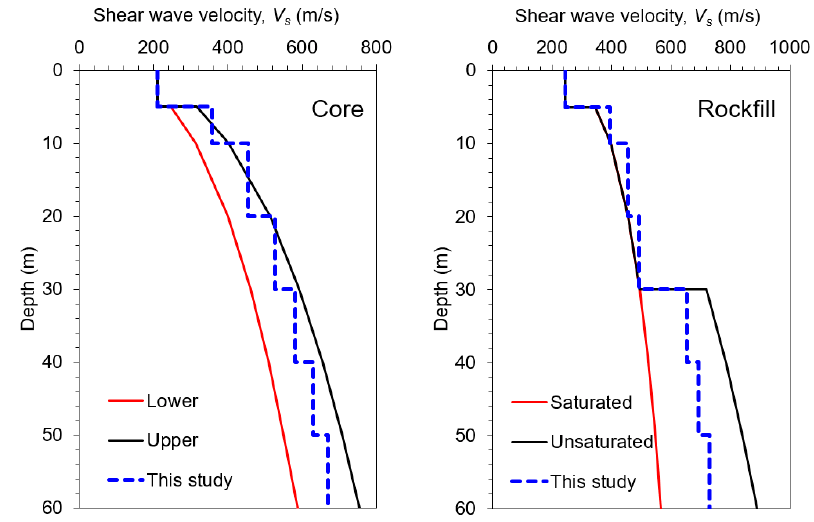
Figure 2. Shear wave velocity profiles of the rockfill and the core.